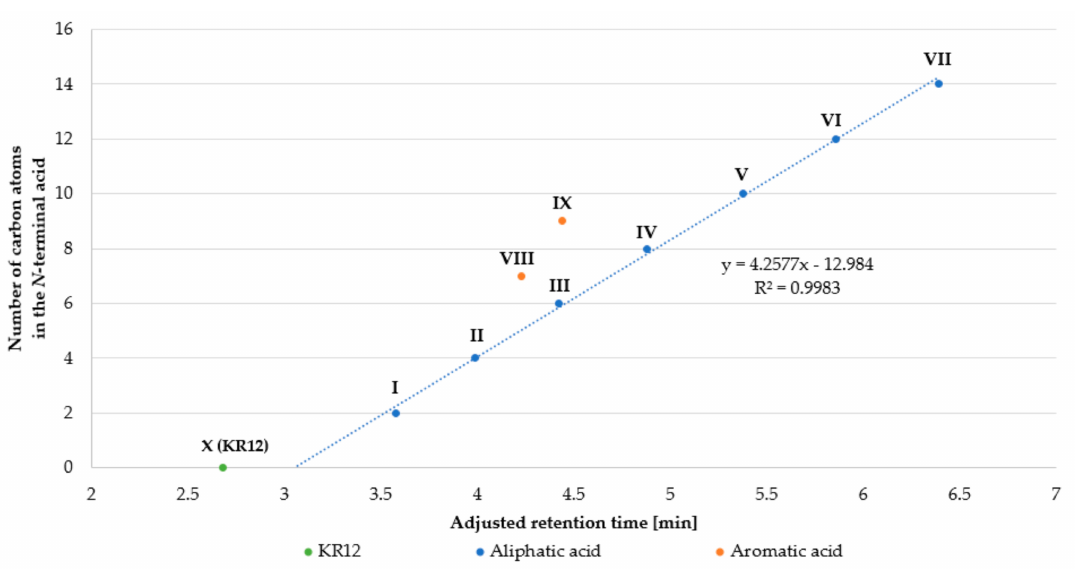
Figure 1. The number of carbon atoms in the N -terminal acid residue versus adjusted retention